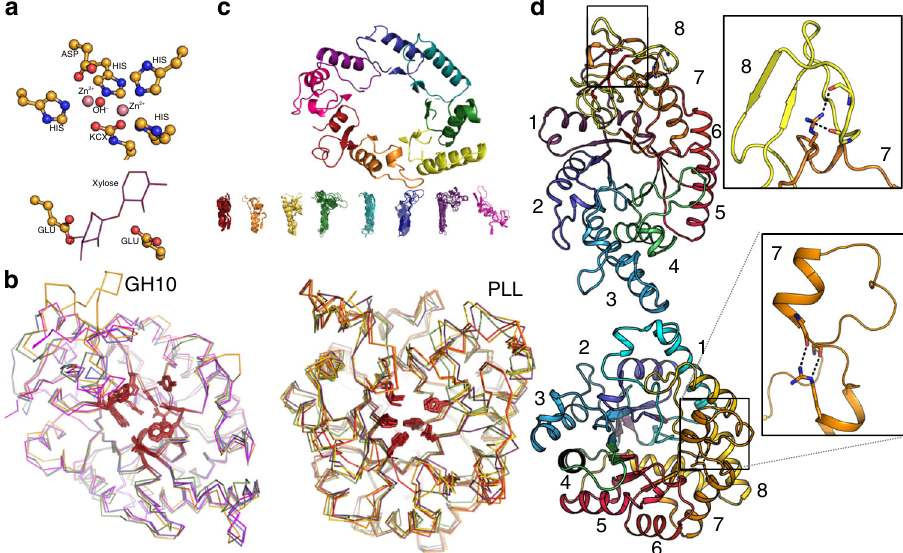
Fig. 1 Combinatorial backbone assembly and design of enzymes. a Active-site constellations of the two targeted enzyme families: (top) PLLs comprising six chelating sidechains (including a carbamylated lysine, KCX), two metal ions, and a hydroxyl ion, and (bottom) GH10s comprising two catalytic Glu sidechains and the substrate. b Active-site pocket residues that are involved in substrate recognition (red sticks) are held fi xed during design. c In combinatorial backbone assembly, homologous but structurally diverse enzymes are segmented along structurally conserved positions to produce exchangeable backbone fragments (bottom). The fragments are computationally recombined and sequence-optimized to generate new low-energy structures. d Irregular, long-range interactions, including buried charges, stabilize β - α backbone conformations. (top) GH10 β - α units 7 and 8 (PDB ID: 4PUE). (bottom) The long β - α loop (16 amino acids) of the P. diminuta phosphotriesterase (PDB ID: